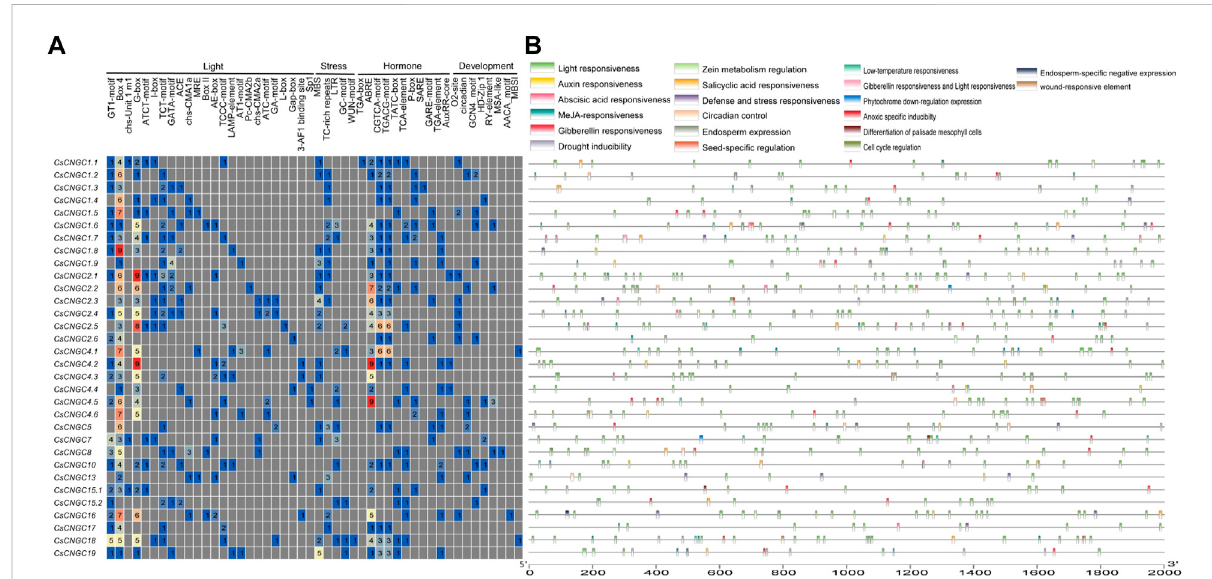
FIGURE 6 Cis-elements analysis done on promoter regions of CsCNGC . (A) The different colors and numbers represent the number of promoter elements in CsCNGC genes. (B) Colored bars represent cis-elements of different types and their locations in each CsCNGC gene. The types, numbers, and locations of cis-elements in promoter regions 2 kb upstream of CsCNGC genes were checked by using the PlantCare